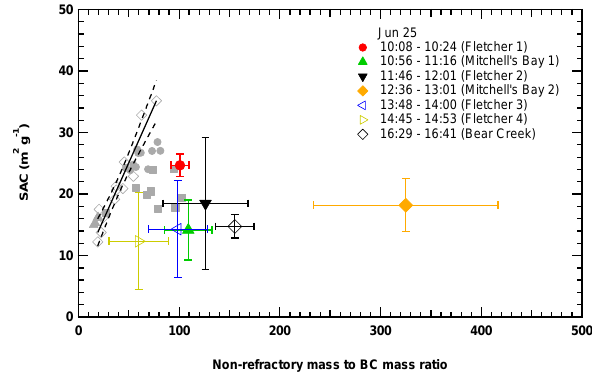
Figure 6: Relationship between SAC and the non-refractory mass to BC mass ratio for various locations (Fletcher, Mitchell’s Bay, Bear Creek) in southern Ontario on June 25, 2007, during the mobile deployment of CRUISER. The different measurement locations (Fletcher, Mitchell’s Bay or Bear Creek) and times are represented by different markers. All grey markers are the data points in the original Figure 5. The black solid and dashed lines represent the regression best fit and 95% confidence interval fit of the data points of the sweep period on Jun. 21.